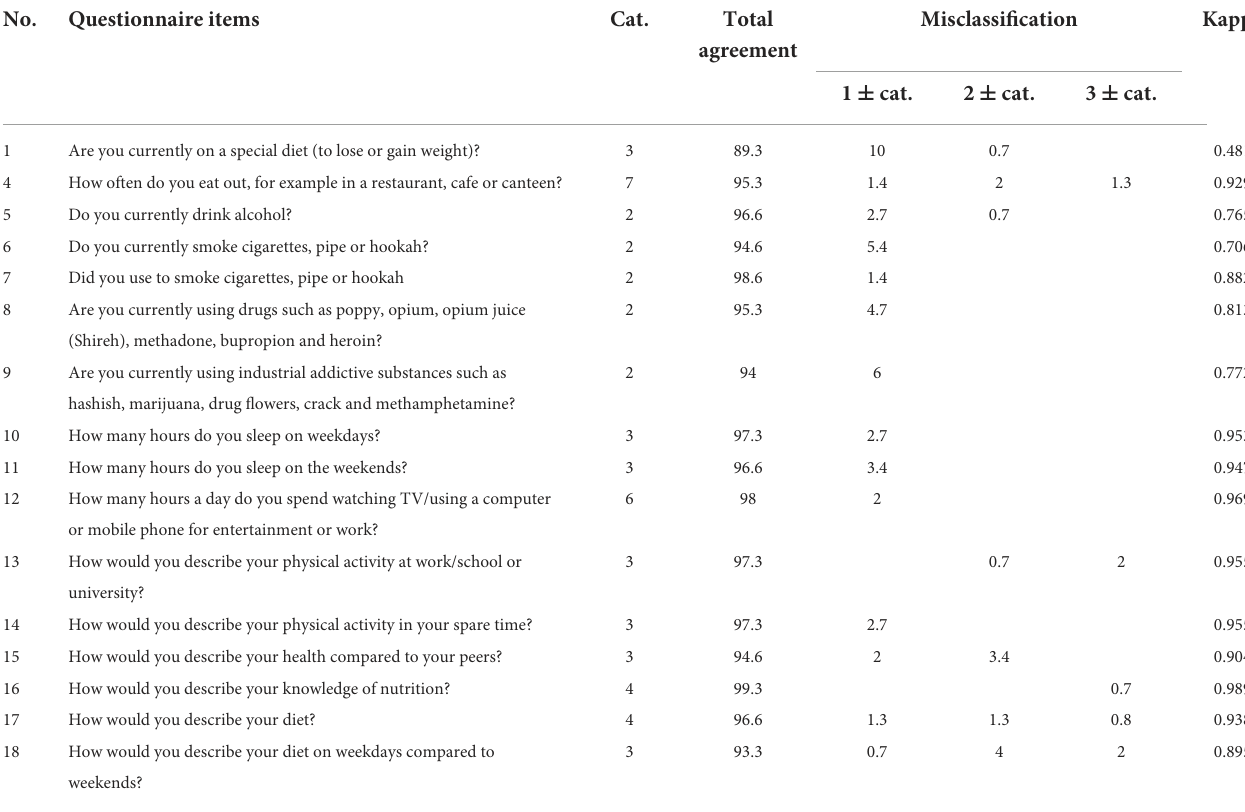
TABLE 6 Agreement and misclassification in test-retest for lifestyle